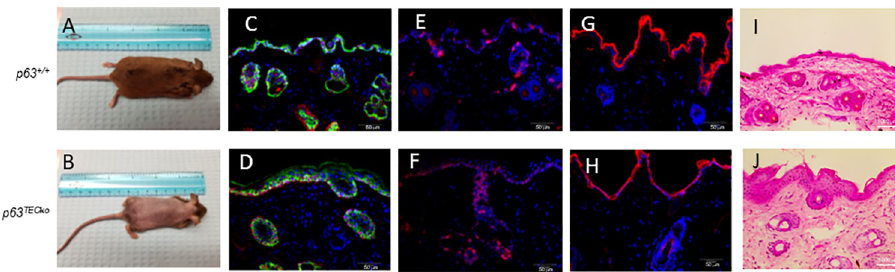
Fig 5. p63 TECko mice have abnormal patches of skin and absent hair follicles. p63 TECko mice are hairless compared to p63 +/+ mice (5B and 5A respectively). Fig 5C and 5D shows Cytokeratin 5 (green), p63 (red) and DAPI (blue); Fig 5E and 5F shows Epcam1 (green), Ki67 (red) and DAPI (blue); Fig 5G and 5H shows Loricrin (red) and DAPI (blue); H and E staining of p63 TECko mice show the absence of hair follicles (Fig 5I and 5J). The scale bars are 50 μ m in 5C to 5H, and 1000 μ m in 5I and 5J. This experiment was performed at least twice with at least three mice per group each